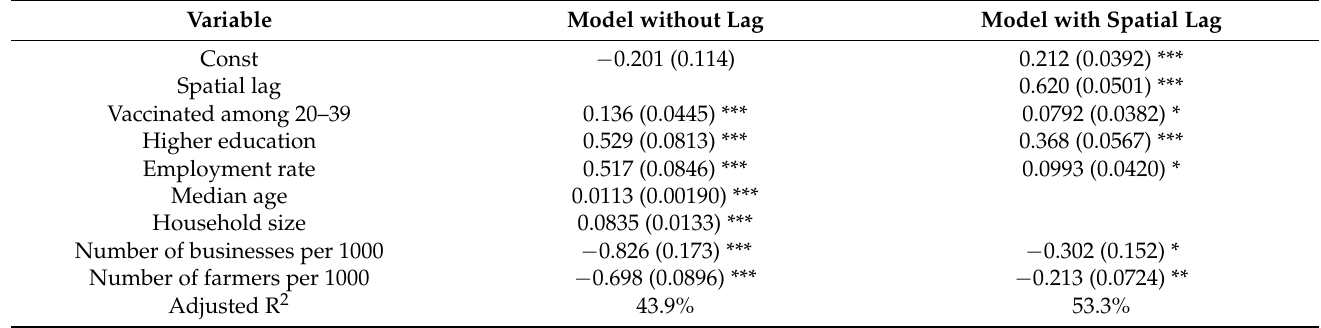
Table 1. Male-to-female ratio of COVID-19 detection among the working-age (25–54 years) population in in the age bracket 25–54 in the period 1 January 2021 to 21 March 2022, corrected for gender imbalance.